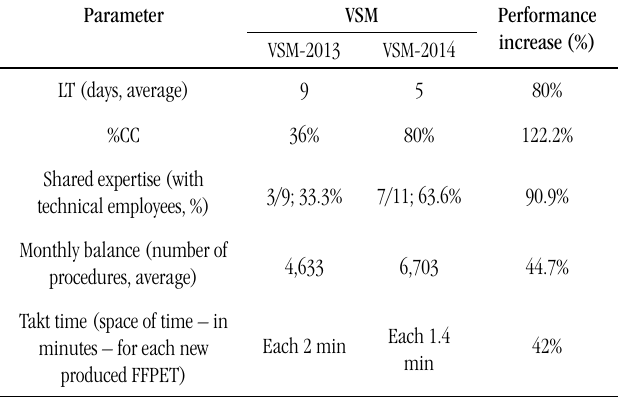
taBLE 1 – Quantifiable gains with VSM-2014 implementation compared to the previous